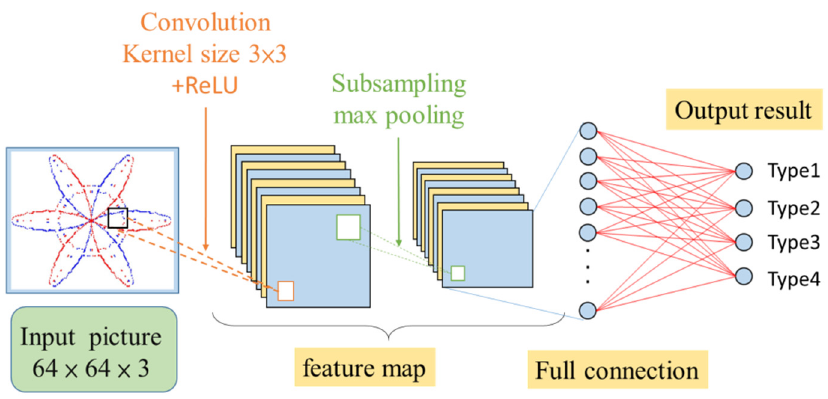
Figure 12. A CNN architecture